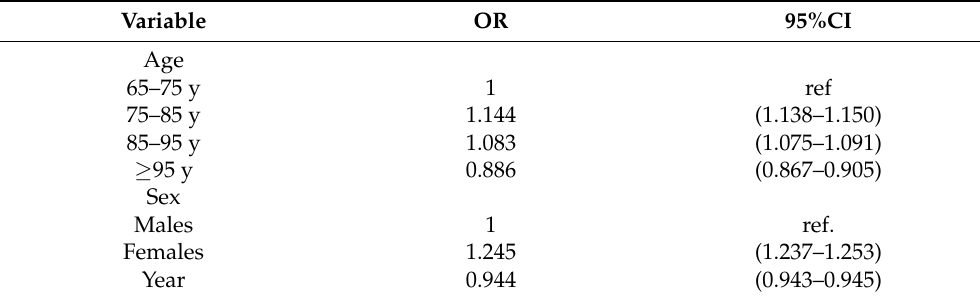
Table 4. Odds ratio (OR) and 95% confidence intervals (95%CI) for the association between age, sex, and calendar year and the probability of being exposed to at least one